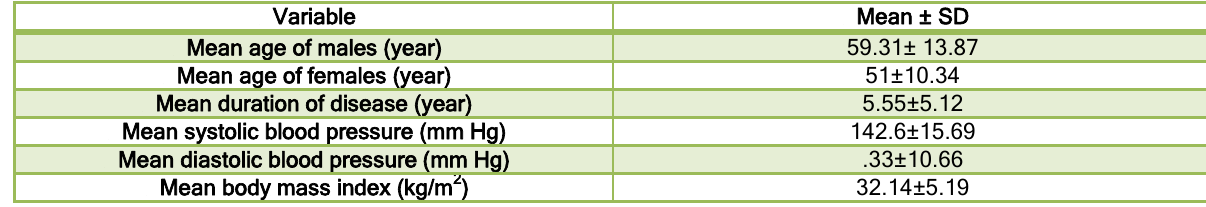
Table 3 Distribution of the studied sample regarding the mean ± SD of continuous variables.